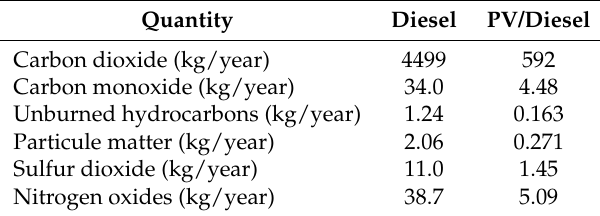
Table 4. Comparison between emissions caused by diesel and hybrid PV-diesel